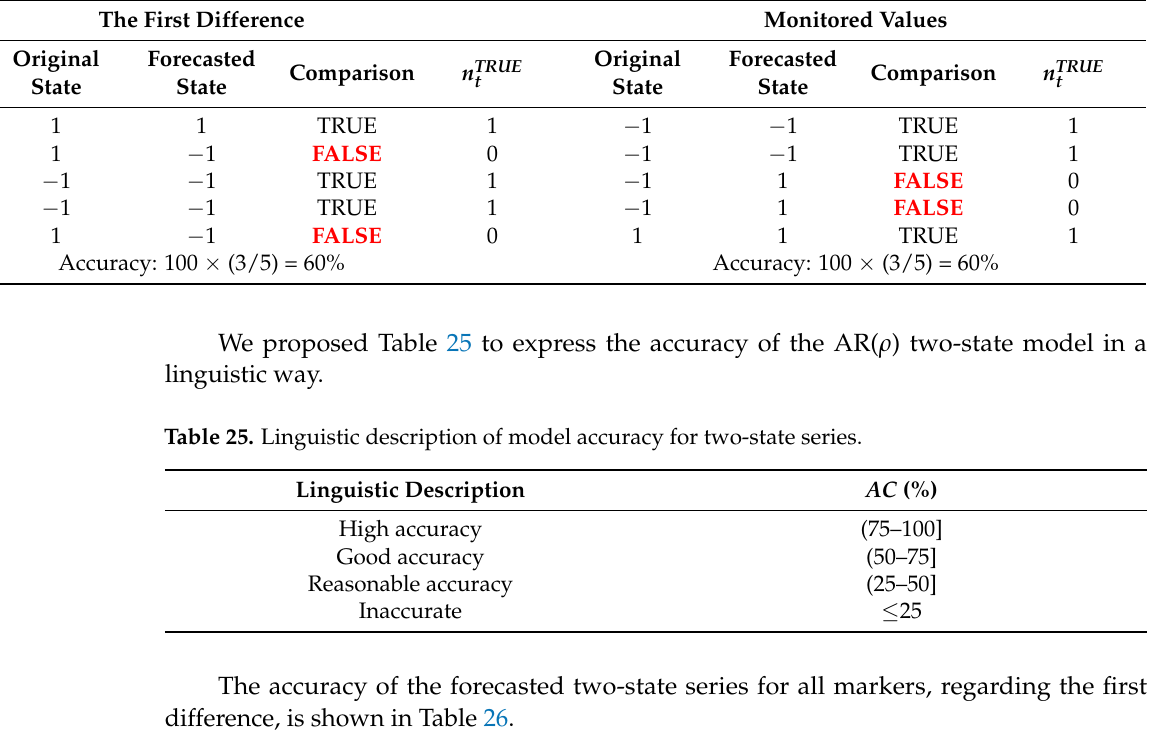
Figure 16. Monitored and fitted two state series for M4 x –original series. The accuracy of the model for forecasting two-state series of marker M4 x , using the AR(10) process, is presented in Table 24. Table 24. Forecasted the first difference and monitored two-state series for M4 x.